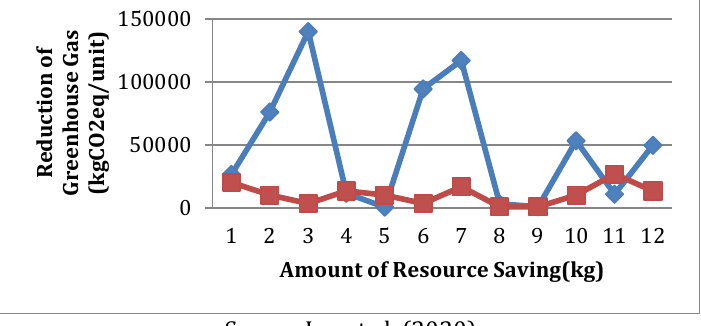
Source : Jun et al. (2020)